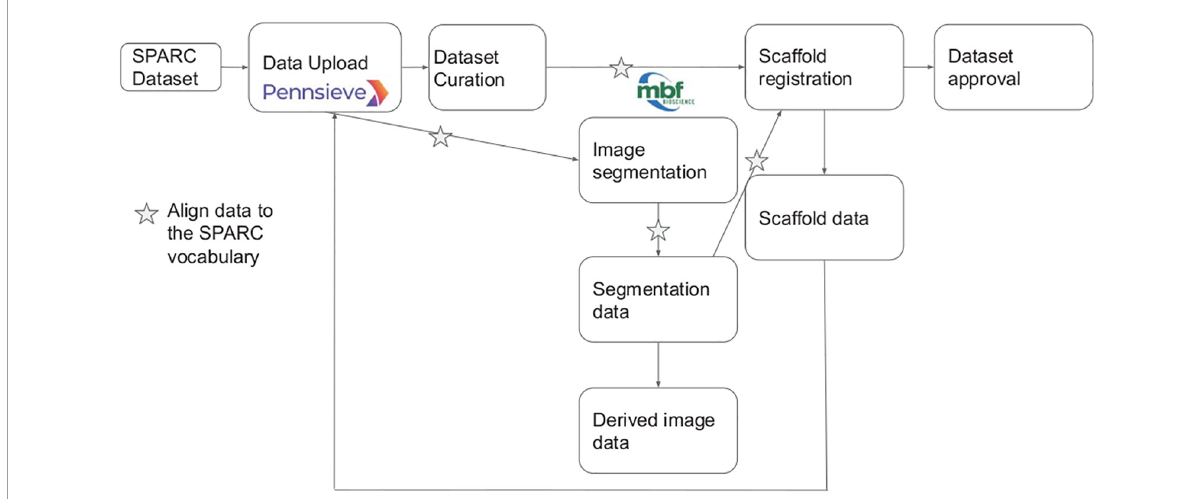
FIGURE3 Overview of SPARC data workflow modified from Osanlouy et al. (2021). Stars indicate steps in the pipeline where the annotation is performed, and terms are most likely to be added to the SPARC